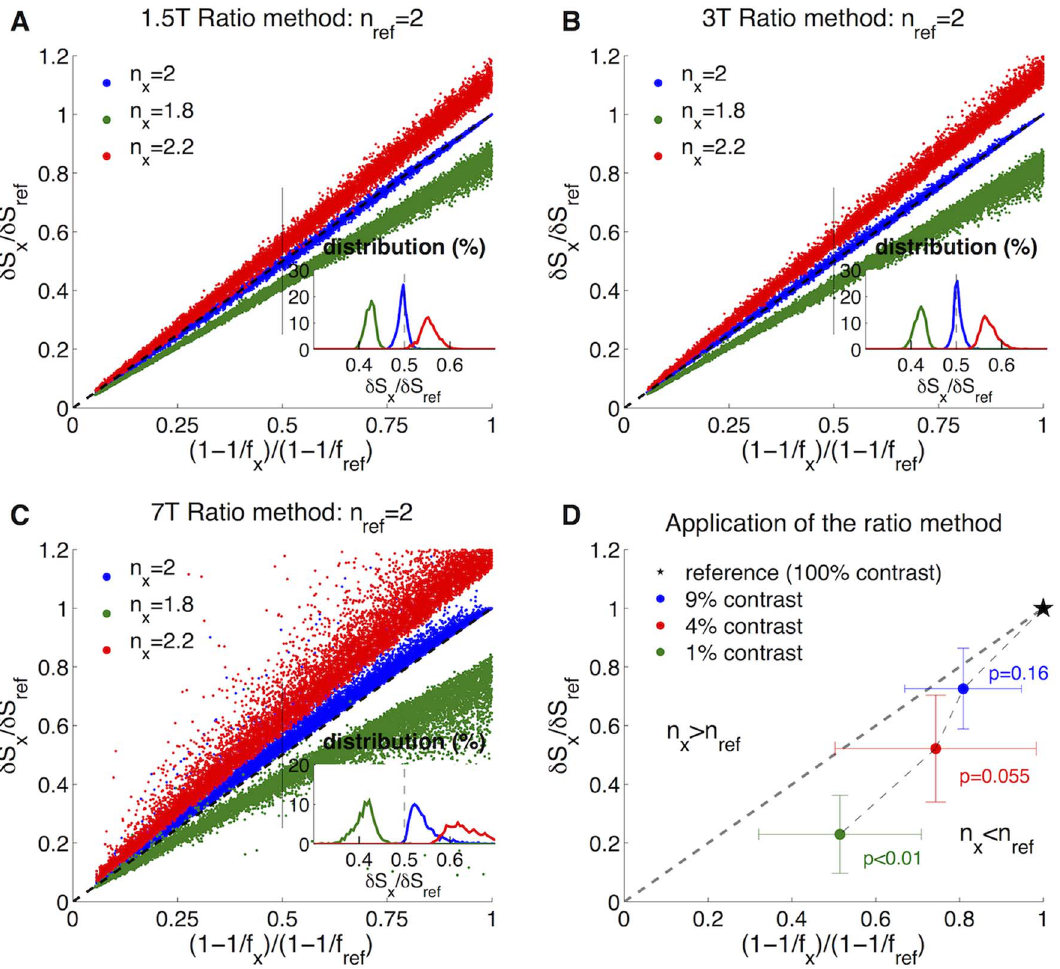
Figure 1. The ratio method for analysis of combined BOLD ( d S) and CBF data. The DBM was used to simulate BOLD data from changes in CBF and set values of n . 10,000 simulations were performed using the ranges for the model inputs noted in Tables 1 and 2. The data was compared to a reference of n ref =2. Inset histograms show the distribution of d S ratios for a non-linear CBF ratio of 0.5. At 1.5T (A) and 3T (B), the ratio method separates the data well while predicting n x = n ref data will fall along the line of identity. At 7T (C), the ratio method does not perform as well, particularly for n x = n ref for which the data deviates from the line of identity. (D) Application of the ratio method to data examining the effect of visual stimulus contrast on the coupling of CBF and CMRO 2 in 9 subjects. 100% contrast flickering checkerboard was used as the reference with results showing that 1% contrast has a significantly lower n .